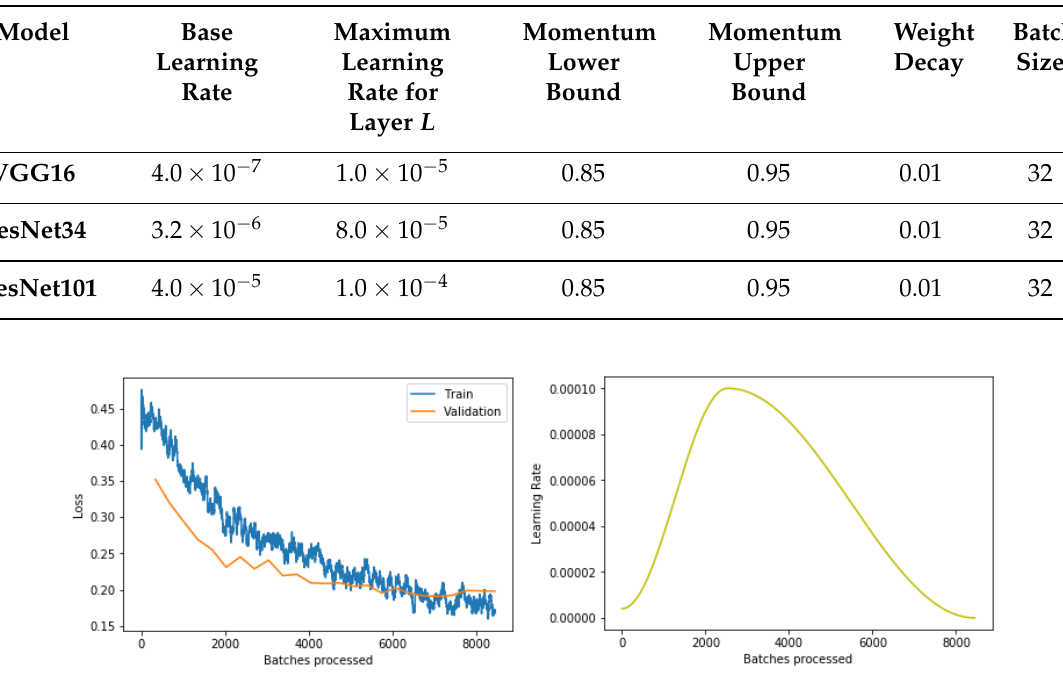
Table 6. Hyper-parameters for training the models used in this work.